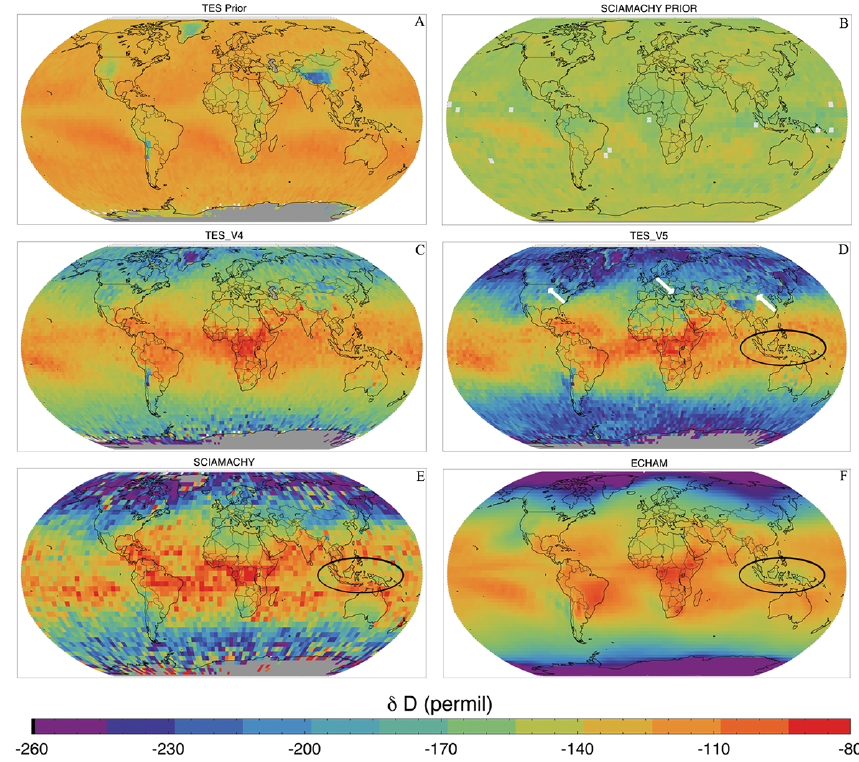
Figure 1. TES prior version 4 (a) , SCIAMACHY prior (b) , δ D product from TES V4 (c) , TES V5 (d) , SCIAMACHY (e) , ECHAM (f) . The figures of TES prior and TES V4 are weighted averaged between 850 and 500hPa, and TES V5 and ECHAM between 900 and 425 hPa. The results are bias-corrected by 5 and − 5‰ for TES V4 and SCIAMACHY, respectively. Arrows in (d) point out the continental effect, and ellipses in (d) , (e) , and (f) show the region with a strong isotope amount effect around Indonesia. All plots are annual average δ